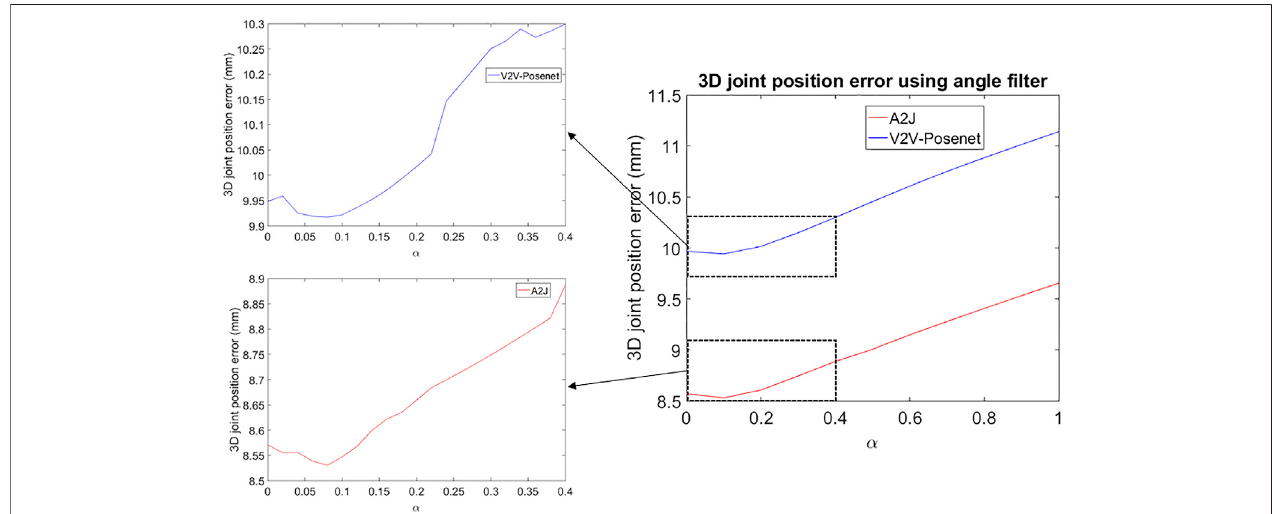
FIGURE 7 | Graphical visualization of the results of two state-of-the-art models, namely A2J (Xiong et al., 2019) and V2V-Posenet (Moon et al., 2018) using the angle fi lterattachedtotheendofthemodelforeveryvalueof α .Thex-axiscorrespondstothevalueof α usedforthe fi lter.They-axisisthemean3Djointpositionerrorof the model,whichisthemeandistanceofeach jointoftheestimated posetothecorrespondinggroundtruth pose.Since theimprovementisminor,azoomed version of the selected regions is also shown for the respective models.